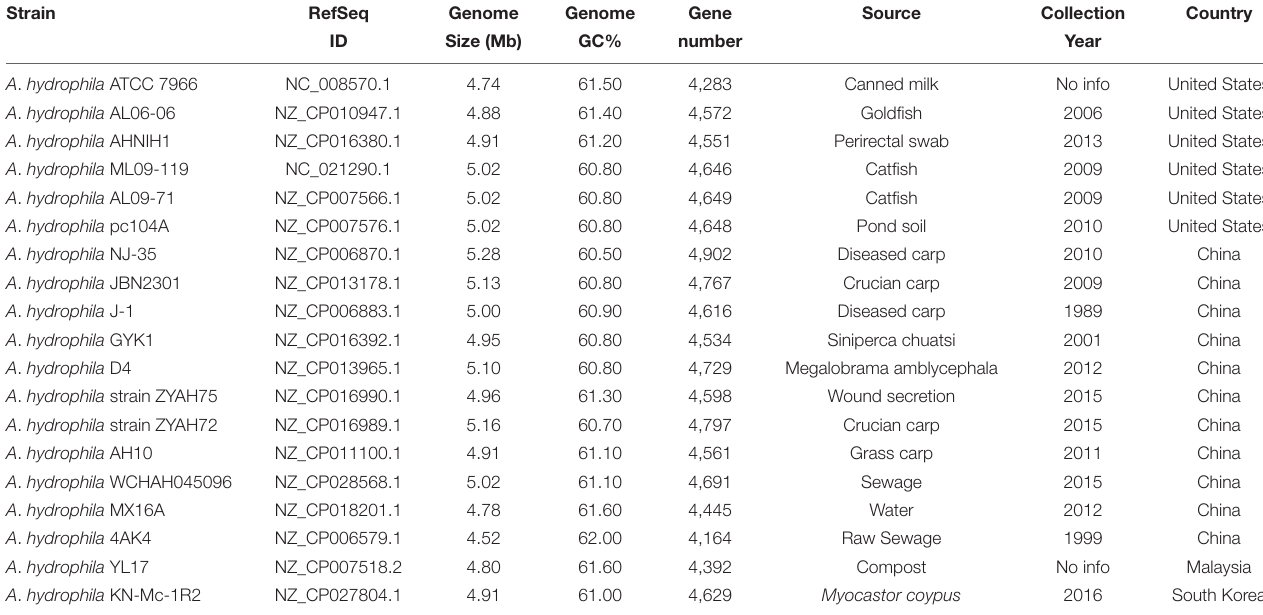
TABLE 1 | General characteristics of Aeromonas hydrophila. Strain RefSeq Genome Genome Gene